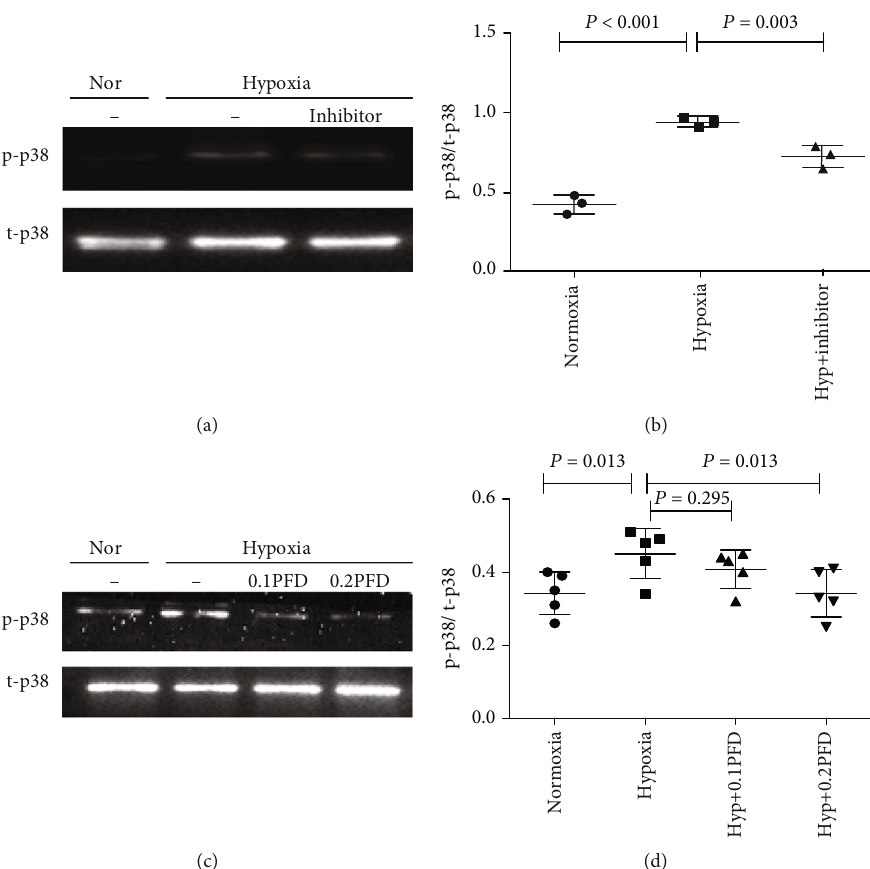
Figure 4: PFD treatment reduced hypoxia-induced p38 phosphorylation in HPAAFs. (a, b) Hypoxia increased the phosphorylation of p38, while preincubation with p38 inhibitor (SB203580, 5mM) reduced the expression of p-p38 ( n = 3 ). (c, d) PFD treatment reduced hypoxia- induced p38 phosphorylation in HPAAFs ( n = 5 ). Nor: normoxia; Hyp: hypoxia; SB203580: p38 inhibitor; PFD: pirfenidone; HPAAFs: human pulmonary arterial adventitial fi